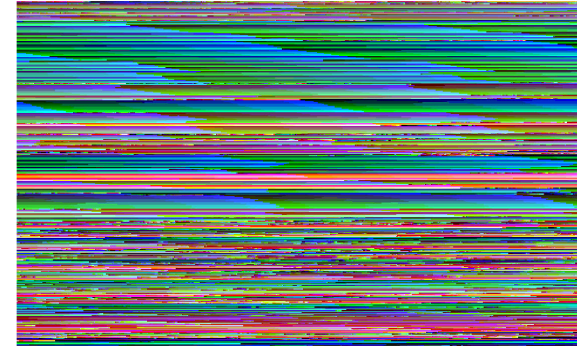
Figure 6 | Shakespeare Machine, Rubin & Hansen, 2012. Figure 7 | 1:1, Jevbratt,